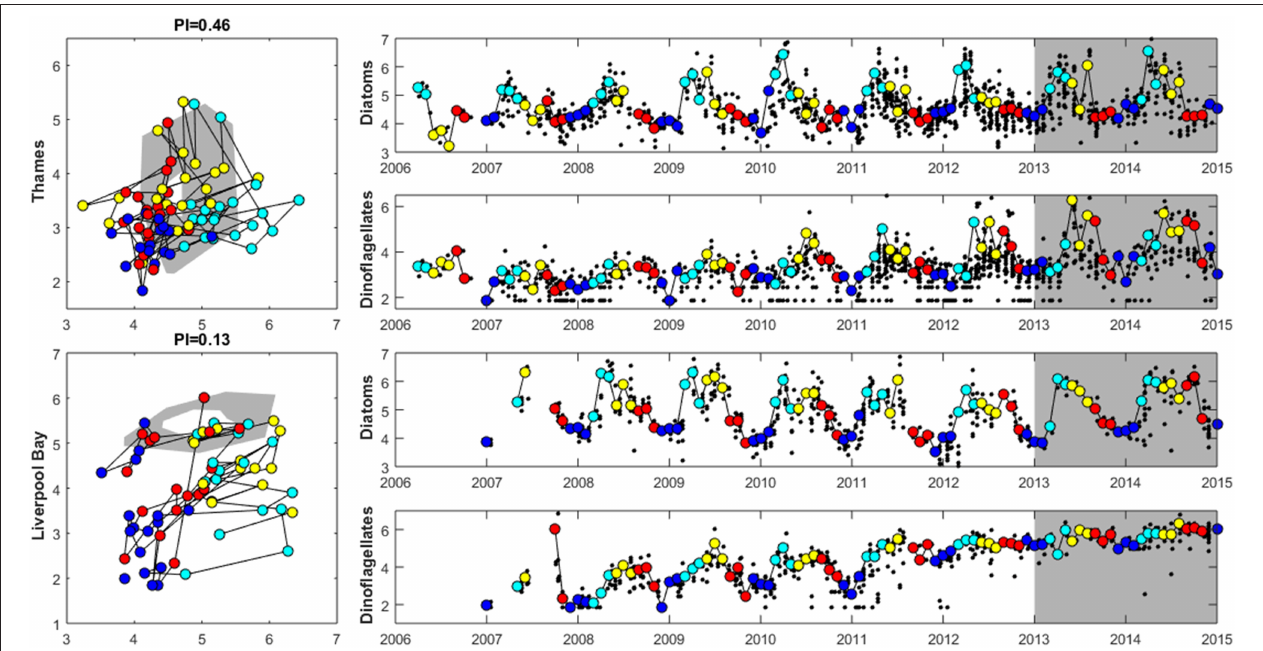
FIGURE 8 | Plankton Index results for the Thames (top) and Liverpool Bay (bottom) plume typologies. The plots on the left show the data for 2006 to 2012 plotted compared to the reference envelope (2013–2015) in gray. The time series on the right show log10 (cell counts) for diatoms and dinoflagellates. Small black dots in the time series represent every observation, and the colored points (and line connecting them) match those in the PI diagram with colors indicating season: The reference period data (highlighted in gray in the timeseries) are not shown in the PI diagram. Dark blue: December–February, light blue = March–May, yellow = June–August, red =